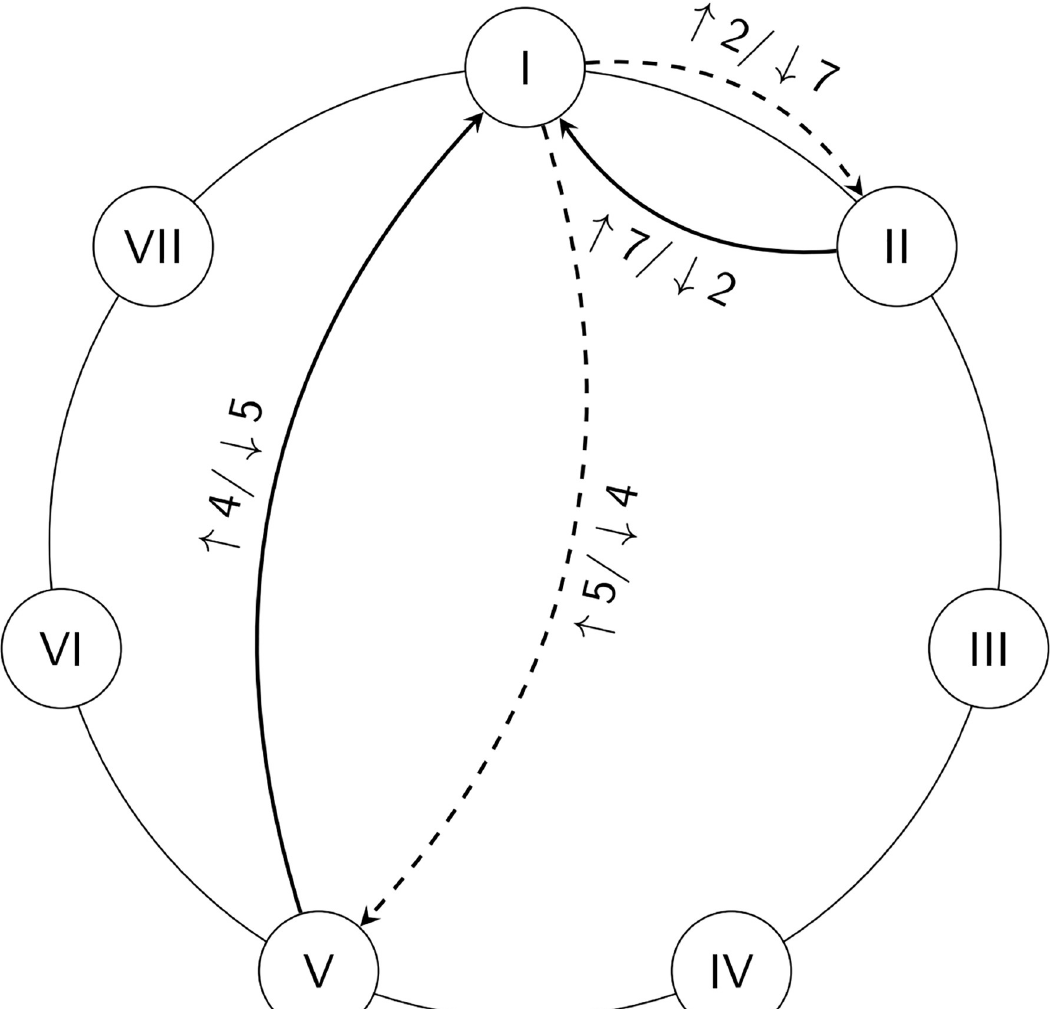
Fig 9. Examples of chord root progressions. Authentic root progressions are shown as solid arrows and plagal root progressions are shown as dashed arrows. Note that the example shows progressions involving I .